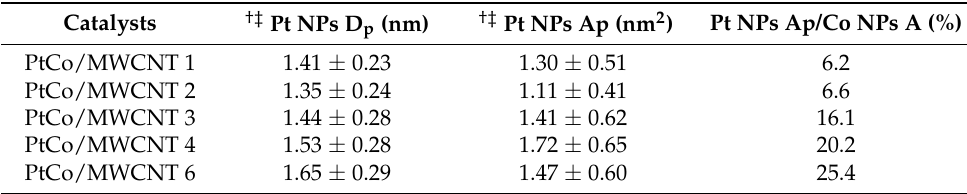
Table 1. Morphological parameters and crystallite size of the PtCo